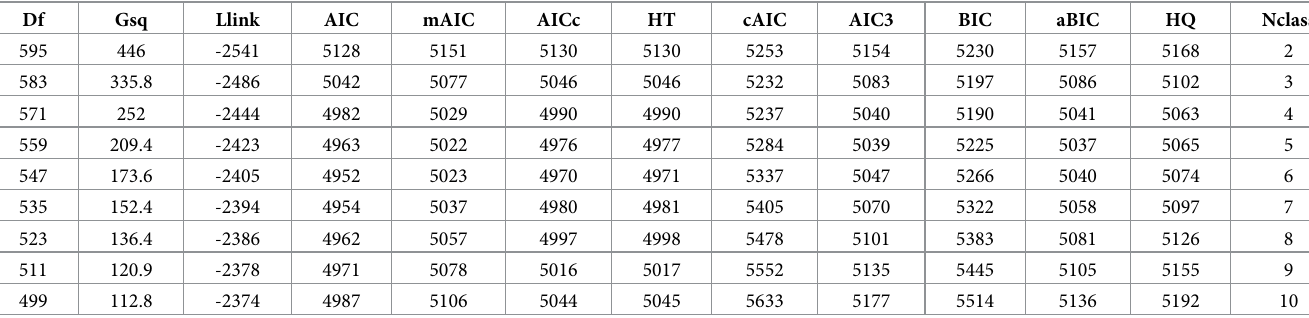
Table 2. Information criteria for the selected classification variables.